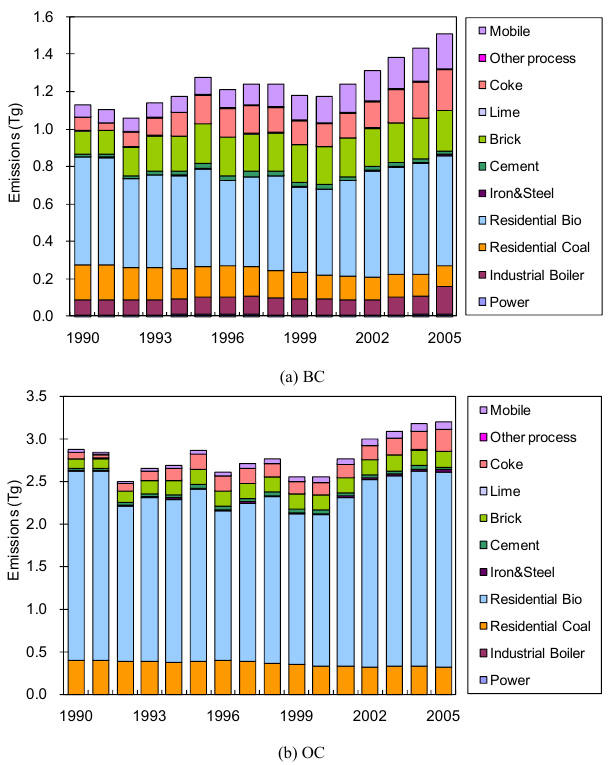
Fig. 7. Emissions of (a) BC and (b) OC from 1990 to 2005.